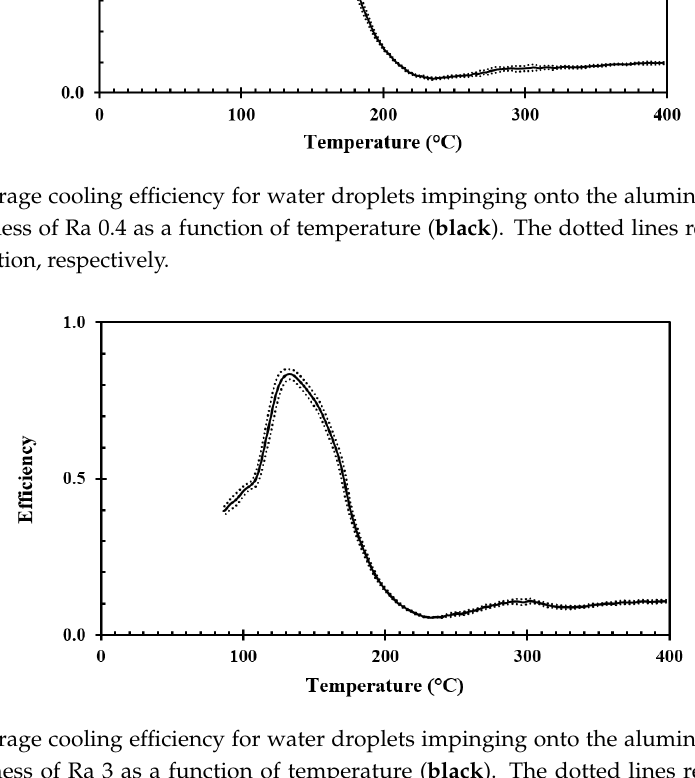
Figure 14. Cooling efficiency standard deviation for water droplets impinging onto the aluminum disc with surface roughnesses of Ra 0.4 and Ra 3 (marked on the figure). The average results for the aluminum discs with surface roughnesses of Ra 0.4 and Ra 3 are compared in Figure 15.